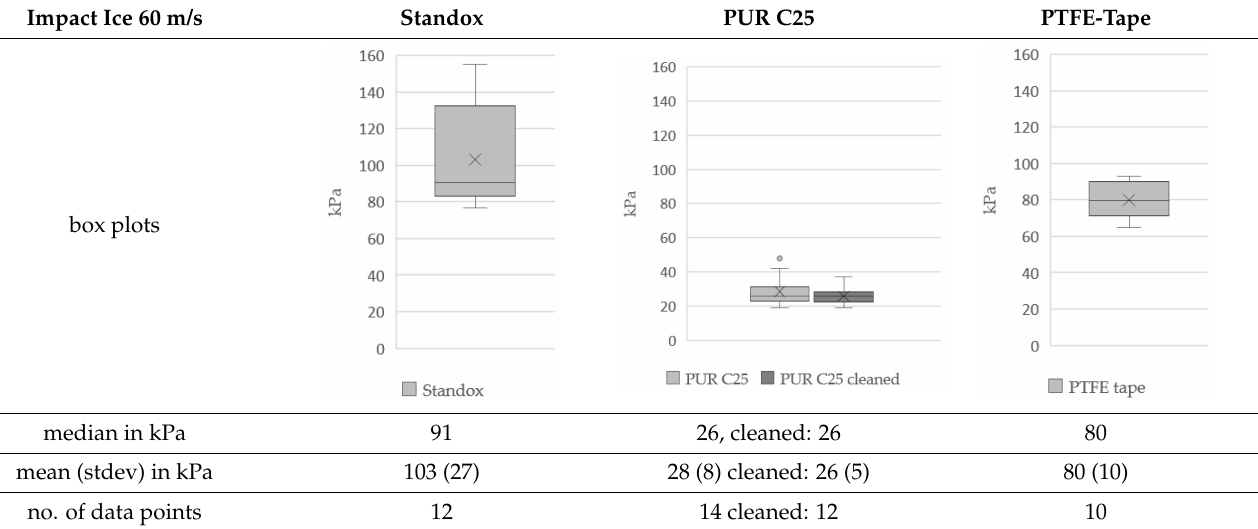
Table 6. Ice adhesion centrifuge test results for impact ice (60 m/s; acceleration speed 200 rpm/s) with relevant statistical data for result evaluation (given “cleaned” values based on outlier replacements after box plot